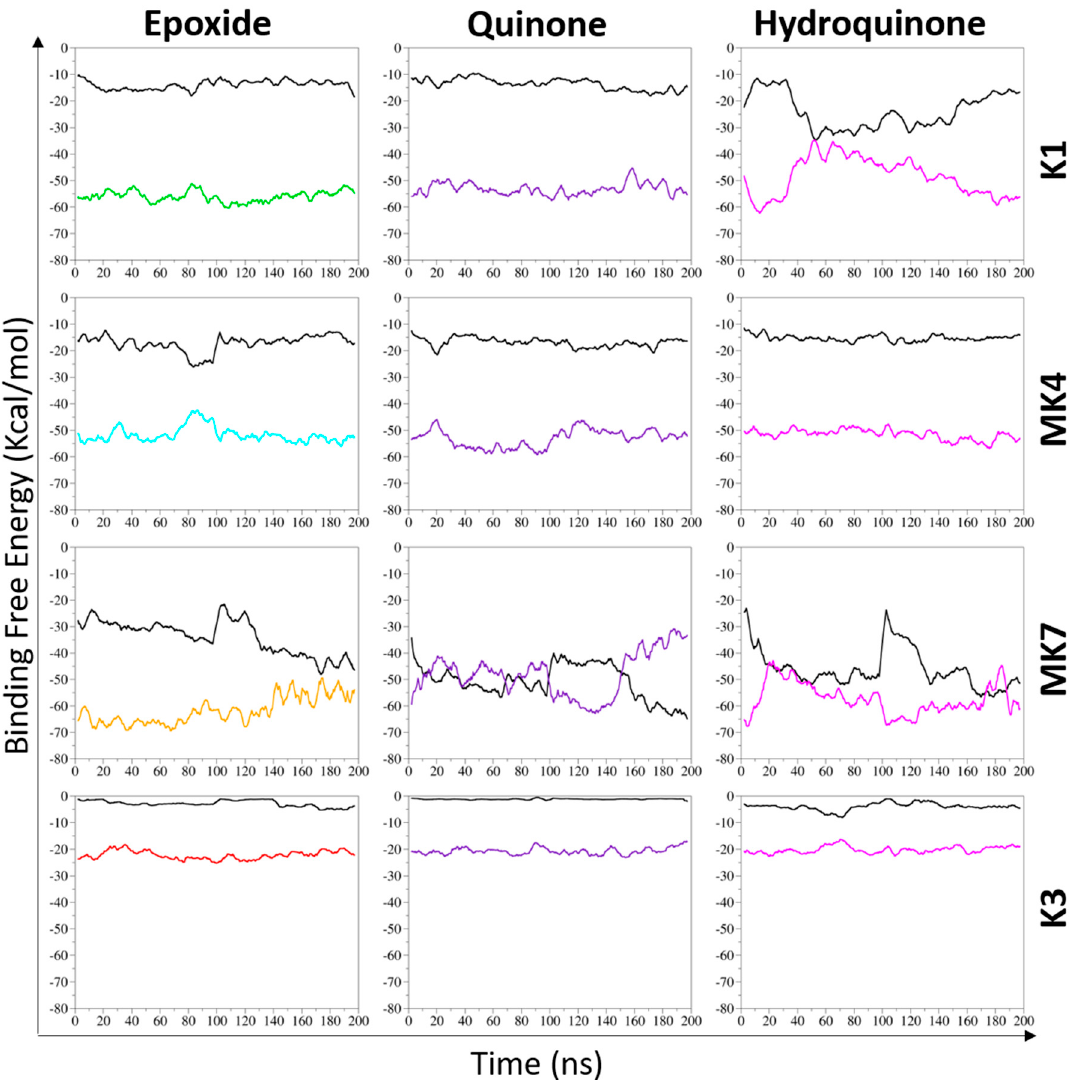
Figure 7. Binding free energy of vitamins K (K1, MK4, MK7, and K3 in their epoxide, quinone, and hydroquinone states) towards vitamin K epoxide reductase (VKORC1) and membrane in molecular dynamics (MD) simulations. The binding free energy (BFE) between vitamin K and membrane is shown as black line. The BFEs between the epoxide state of vitamin K and VKORC1 are shown as green, cyan, orange, and red lines for vitamin K1, MK4, MK7, and K3, respectively. The BFEs of quinone and hydroquinone states of vitamins K towards VKORC1 are presented as violet and pink lines, respectively. Two 100-ns MD simulations were performed on each vitamin K–VKORC1 complex, then concatenated to be considered as one 200-ns MD simulation.